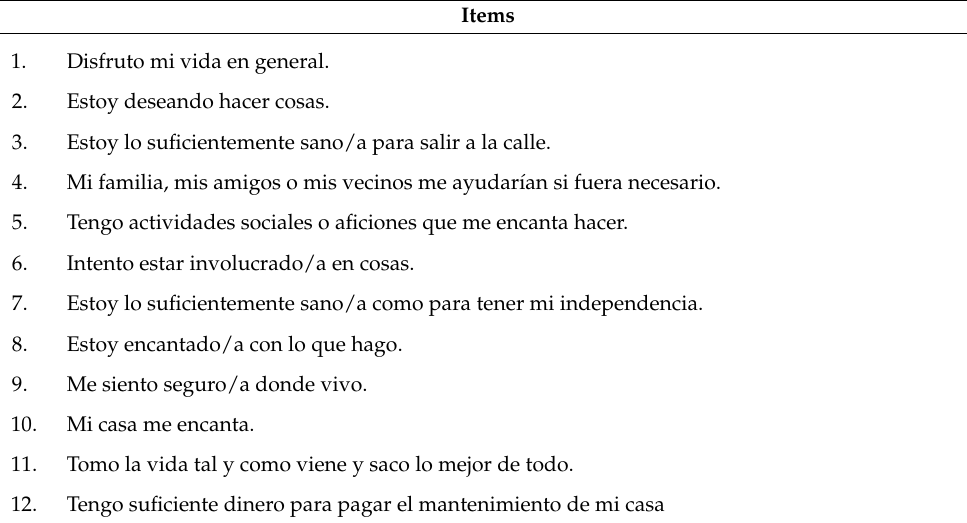
Table A1. Spanish version of the OPQOL-Brief